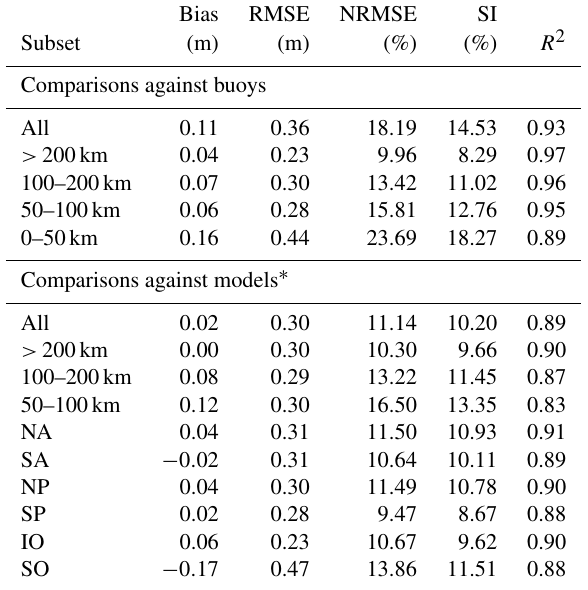
Table 5. Statistical metrics based on altimeter–buoy and altimeter– model comparisons for different subsets of data (see Fig.